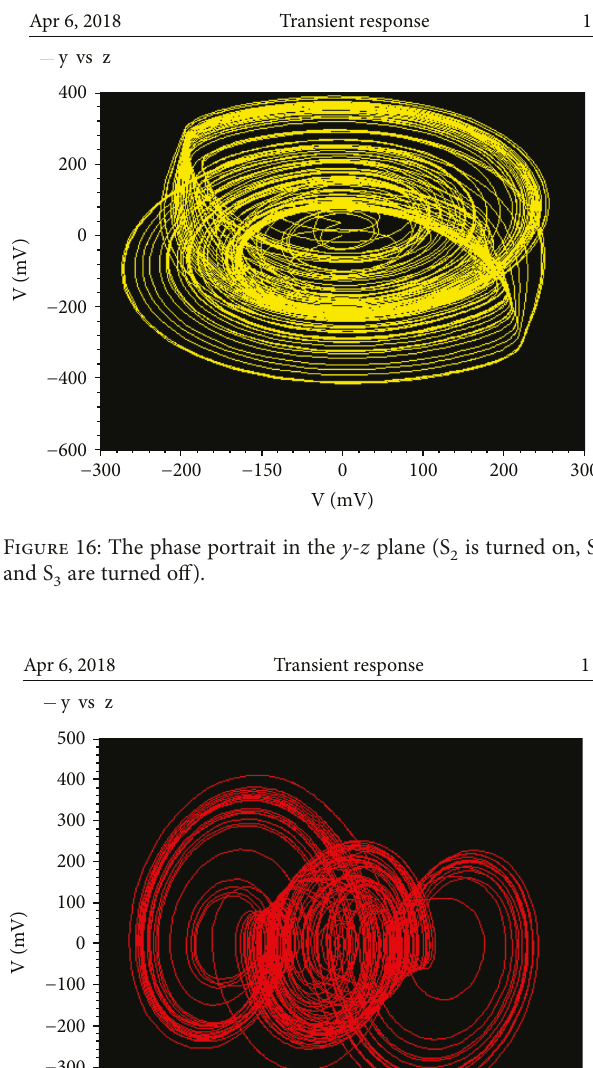
and S are turned 1 3